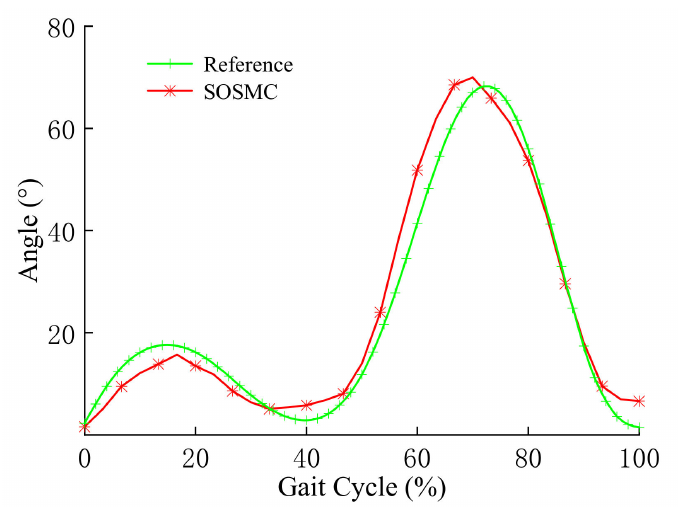
Figure 20. Knee joint swing trajectory based on SOSMC.